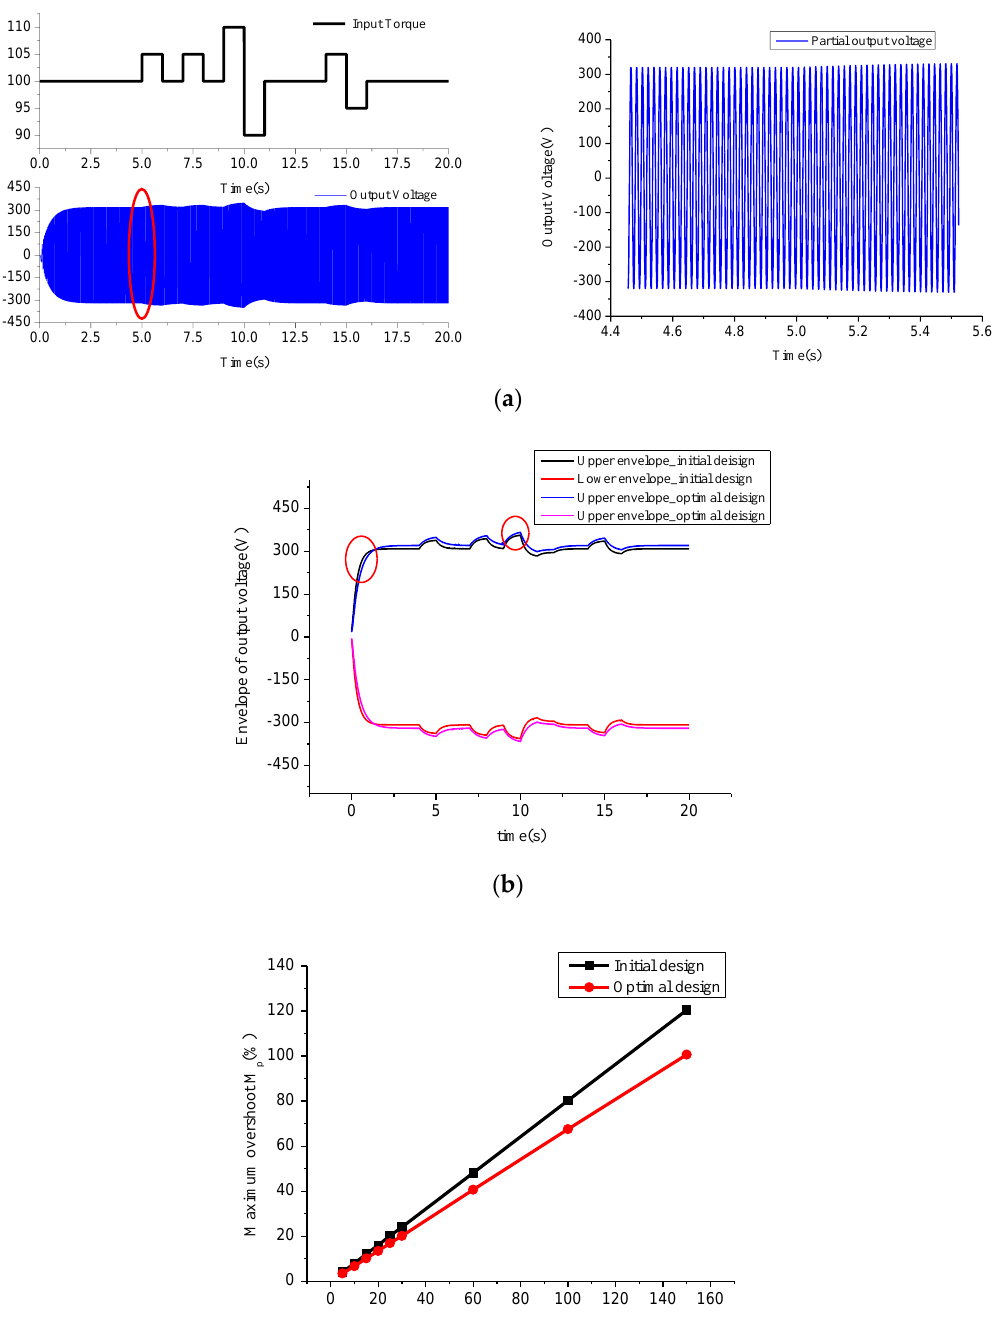
Figure 17. Dynamic performance analysis: ( a ) Output voltage with variable torque input for optimal design and partial detail; ( b ) Envelop comparison of the maximum output voltage before and after optimization; ( c ) Maximum overshoot with different input disturbance torque.